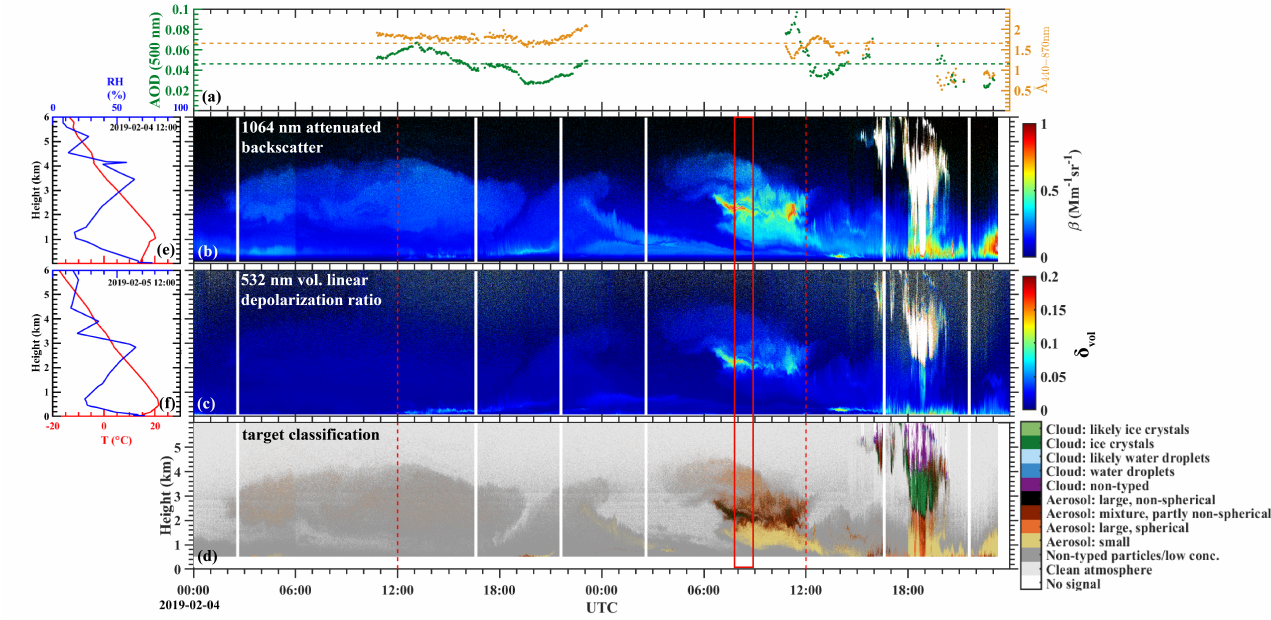
Figure 2. From the upper to the lower panel: ( a ) aerosol optical depth (AOD) at 500 nm and Ångström exponent for 440/870 nm (dashed lines indicate the mean); ( b ) attenuated backscatter coefficient at 1064 nm (Mm − 1 sr − 1 ); ( c ) volume depolarization ratio (% at 532 mn); and ( d ) target classification reflecting the atmospheric conditions over Punta Arenas from 4 February to 5 February 2019. Radiosonde launches are depicted with red dashed lines. The corresponding temperature and relative humidity profiles can be seen on the left panels ( e , f ). Vertical white lines indicate the automatic calibration of the linear depolarization ratio (Engelmann et al. [9]). The averaging period for the profiles shown in Figure 5 is indicated by the red